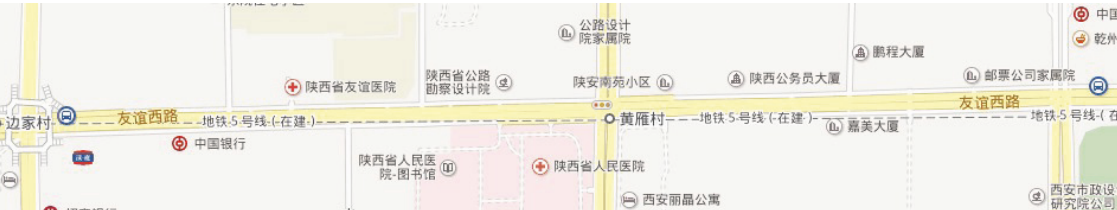
Figure 2: Schematic diagram of three-intersection trunk line.